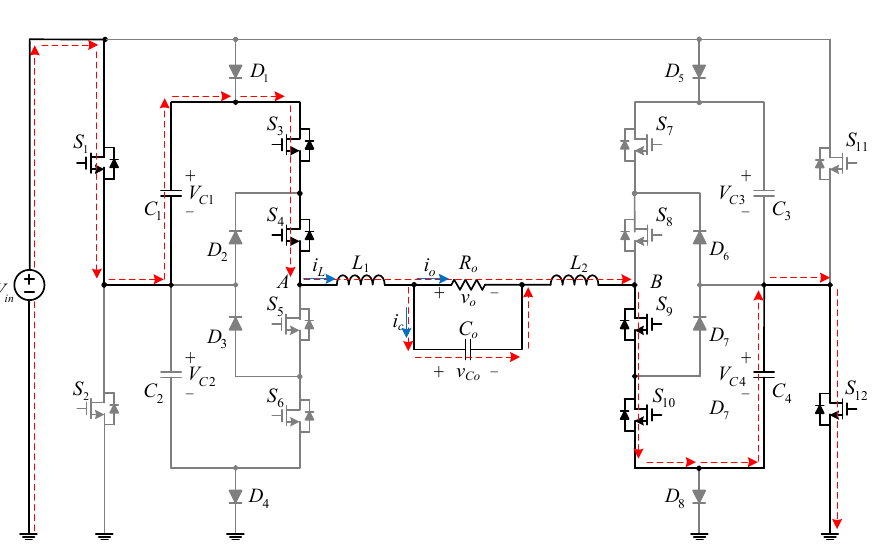
Figure 10. Gate driving signal for S 10 . Interval [ t 6 ≤ t ≤ t 7 ] : The switches S 1 , S 3 and S 10 are turned on. As shown in Figure 11, the current flowing through the inductors L 1 and L 2 will form a circuit loop from the input voltage to the switches S 1 , S 3 , S 4 , S 9 , S 10 and S 12 ; therefore, the voltage across the terminals A and B is